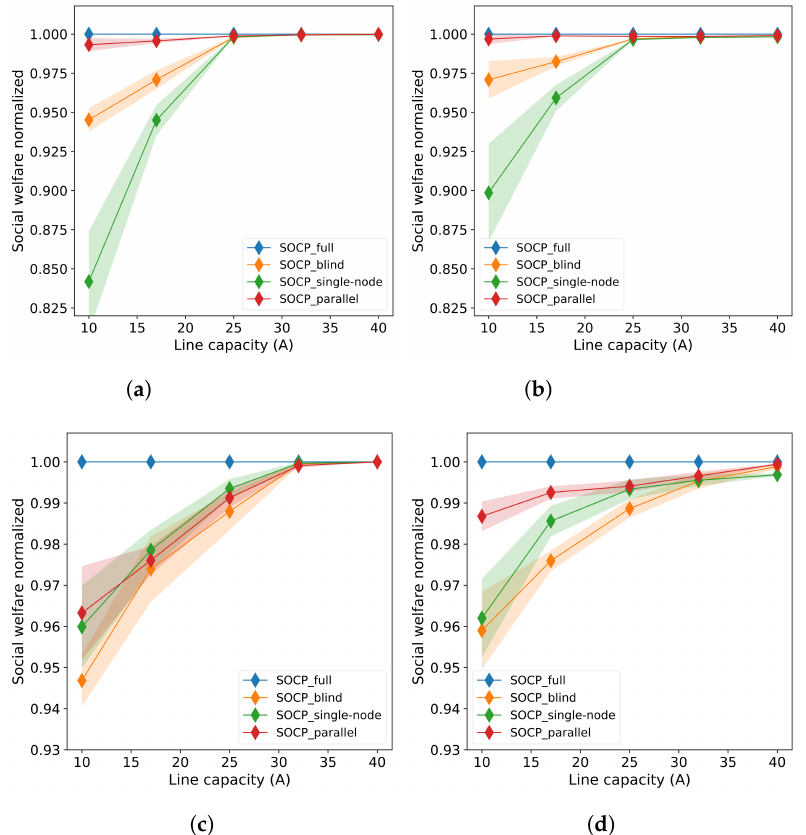
Figure 8. Social welfare provided by the surrogate models, full and blind planners. Values are normalized relative to the full planner. Horizontal axis is the lines’ current limit. ( a ) Radial IEEE16 grid connected to the external grid. ( b ) Disconnected radial IEEE16 grid. ( c ) Meshed IEEE16 grid connected to the external grid. ( d ) Disconnected meshed IEEE16